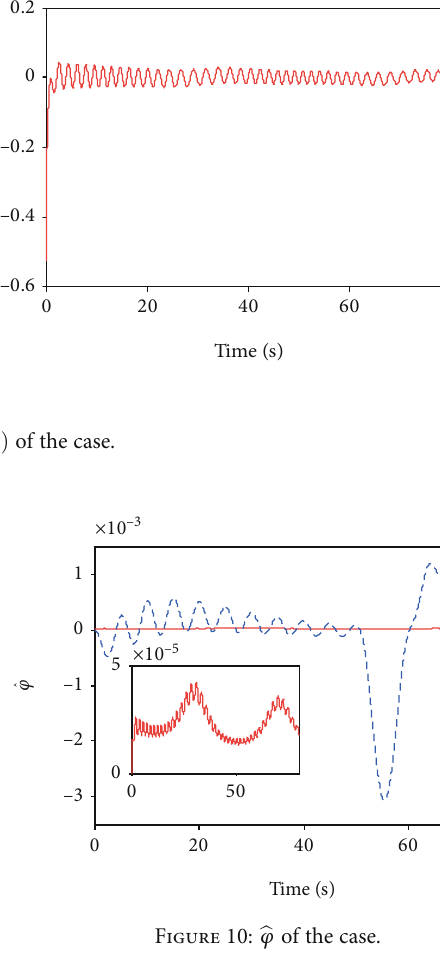
Figure 10: b φ of the